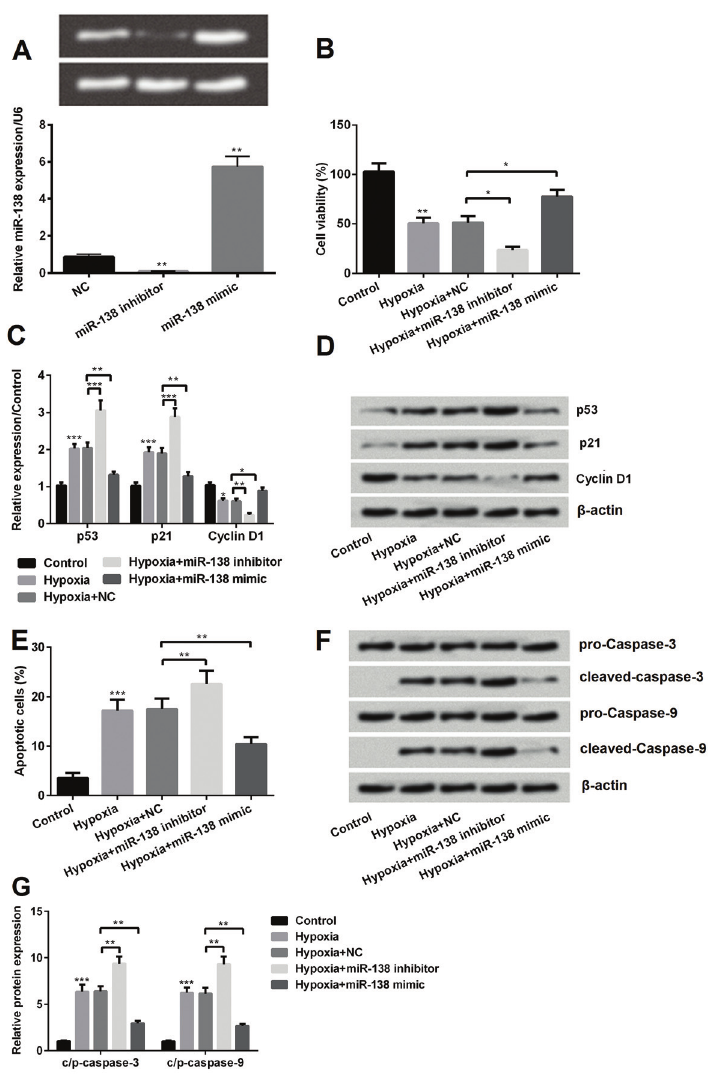
Figure 4. miR-138 overexpression alleviated hypoxia- induced cell injury. A , miR-138 expression was up- regulated or down-regulated after transfection assay analyzed by qRT-PCR. B , miR-138 overexpression up-regulated in hypoxia-treated cells compared with negative control (NC). C and D , The protein expres- sions of p53 and p21 were up-regulated and cyclin D1 was down-regulated by miR-138 overexpression compared with NC. E and F, miR-138 overexpres- sion decreased cell apoptosis and the effects on apoptosis-related proteins were detected by western blot. Data are reported as means ± SD of tripli- cates. Each experiment was performed three times. *P o 0.05, **P o 0.01, ***P o 0.001 compared to con- trol or as indicated (one-way analysis of